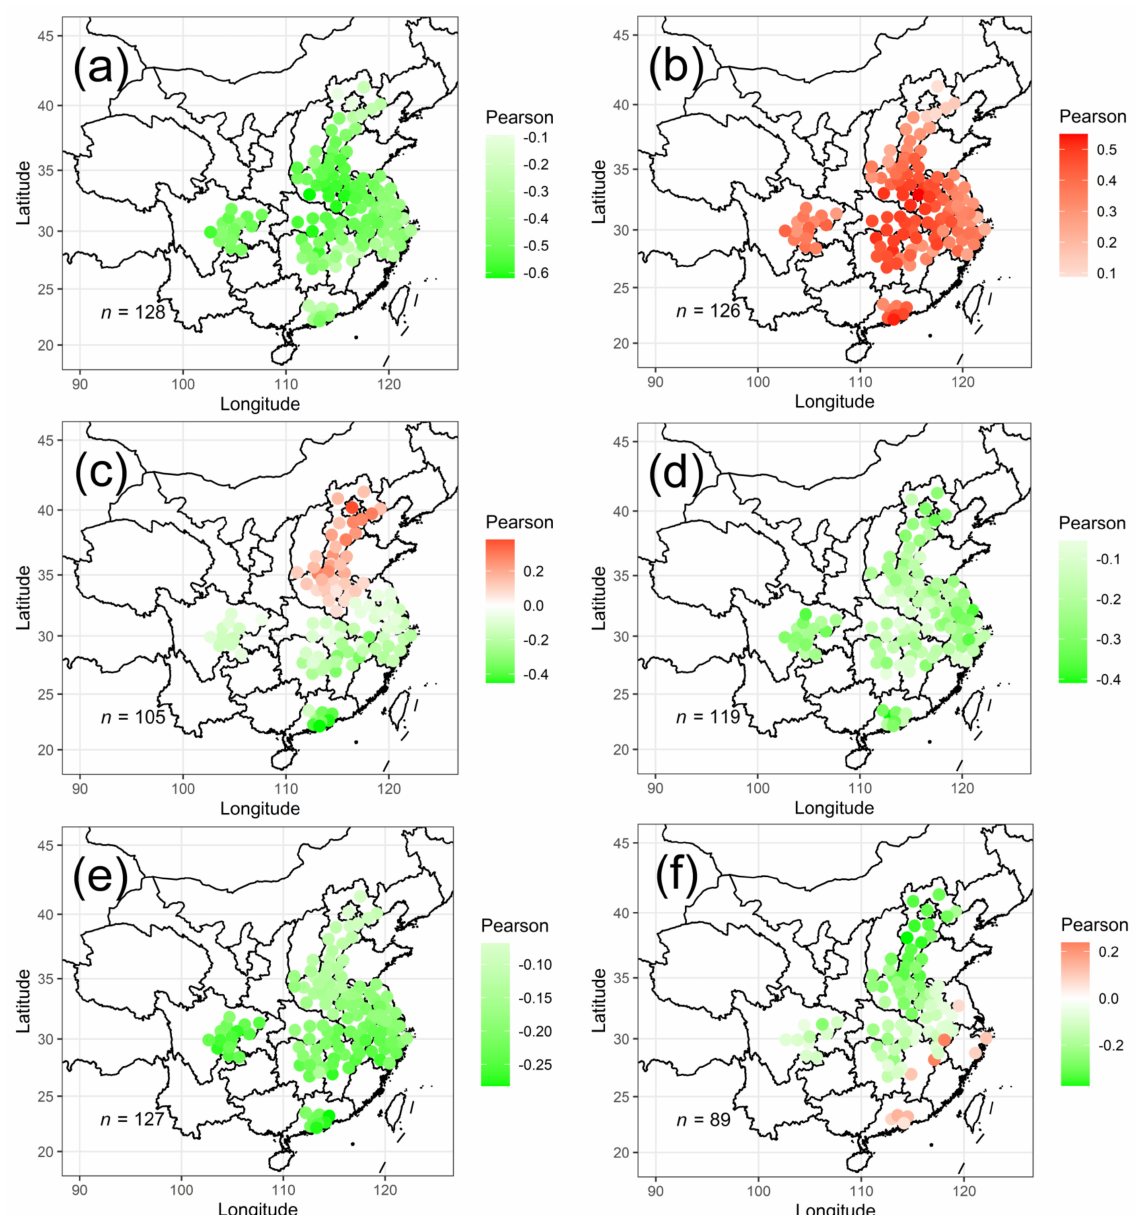
Figure 7. The Pearson coefficient values in six urban agglomerations during the period of 2017–2020: ( a ) correlation between PM 2.5 concentration and T; ( b ) correlation between PM 2.5 concentration and P; ( c ) correlation between PM 2.5 concentration and RH; ( d ) correlation between PM 2.5 concentration and WS; ( e ) correlation between PM 2.5 concentration and Pre; and ( f ) correlation between PM 2.5 concentration and SSD. n refers to the number of sites that pass the significance test at a 95% confidence